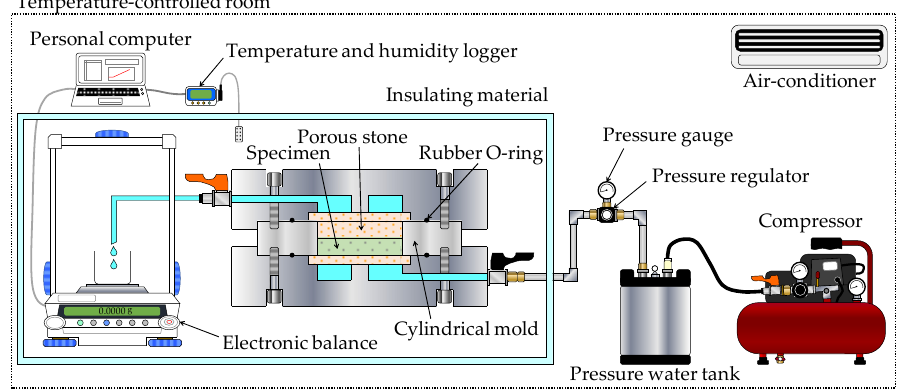
Figure 5. Schematic of the experimental configuration for the constant-pressure permeability test of clay mineral samples [24].